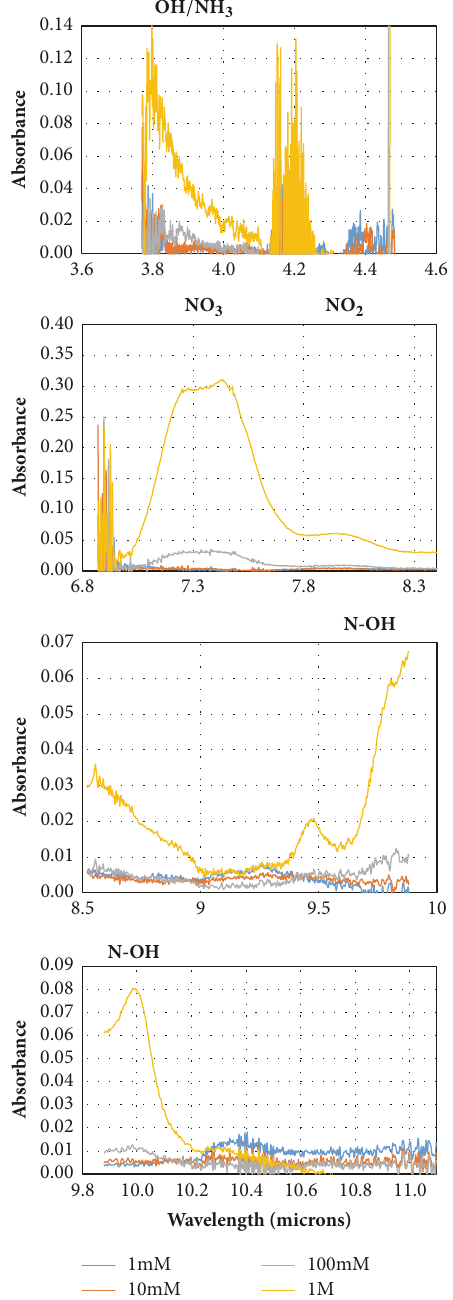
Figure 3: ATR-QCL absorption spectra of hydroxylamine nitrate (1mM to 1 M) across the spectral range of the four QCL lasers used in this study.